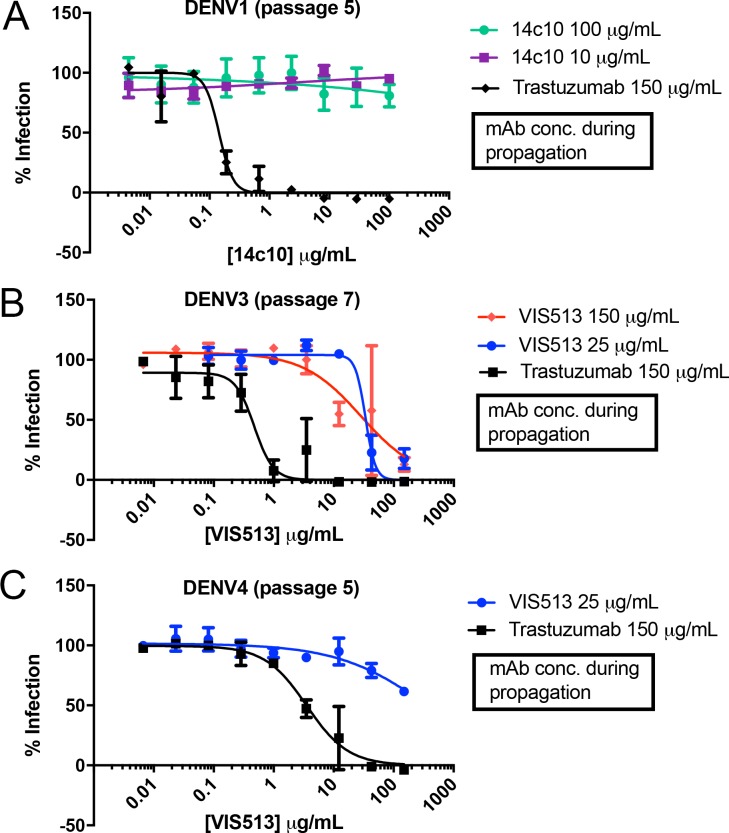
Identification of VIS513 escape mutants.A. Neutralization profile of a titration of 14c10 with DENV1 population passaged in presence of 14c10 at 100 μg/ml, 10 μg/ml, or trastuzumab at 150 μg/ml for 5 passages. B-C. Neutralization profile of a titration of VIS513 with DENV3 (passage 7) (B) or DENV4 (passage 5) (C) passaged in the presence of indicated concentrations of VIS513 or trastuzumab. For DENV4, passaging in the presence of 150 μg/ml VIS513 yielded insufficient virus for subsequent neutralization assays and hence could not be assayed. The solid lines and error bars represent mean ± SEM of experiment performed in triplicate.